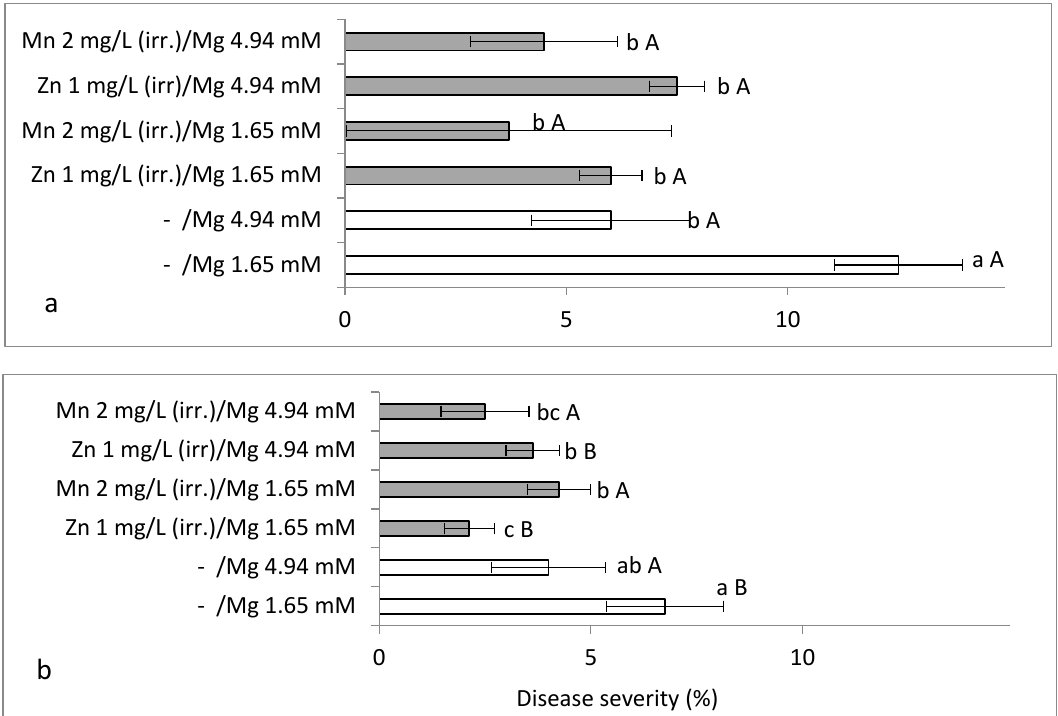
Figure 7. Effects of adding Zn-EDTA (1 mg/L) and Mn-EDTA (2 mg/L) to the irrigation solution so that it contained 1.65 and 4.94 mM/L of those microelements on sweet basil downy mildew (SBDM) severity under field conditions (Spring 2017). Treatments were applied ( a ) alone or ( b ) in combination with fungicides. SBDM severity was evaluated at 104 days after planting on a 0–100% scale, in which 0 = healthy plants and 100% = plants completely covered by disease symptoms. Values within each graph followed by a different lower-case letter and values followed by a capital letter in each pair of treatments without and with fungicides are significantly different according to two-way ANOVA with Tukey’s HSD test. Default significance levels were set at p ≤ 0.05. Bar = SE. DW — dry weight.